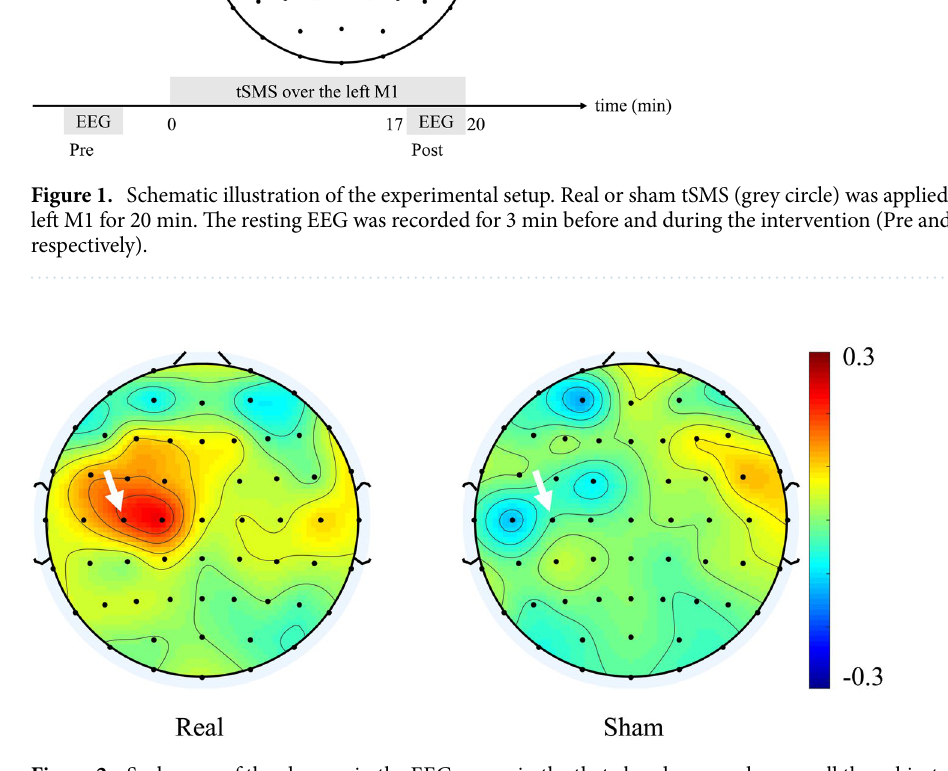
Figure 2. Scalp map of the changes in the EEG power in the theta band averaged across all the subjects for real (left) and sham (right) tSMS. An arrow shows the C3 electrode. Note that the area at C3 was a “hot spot” for real